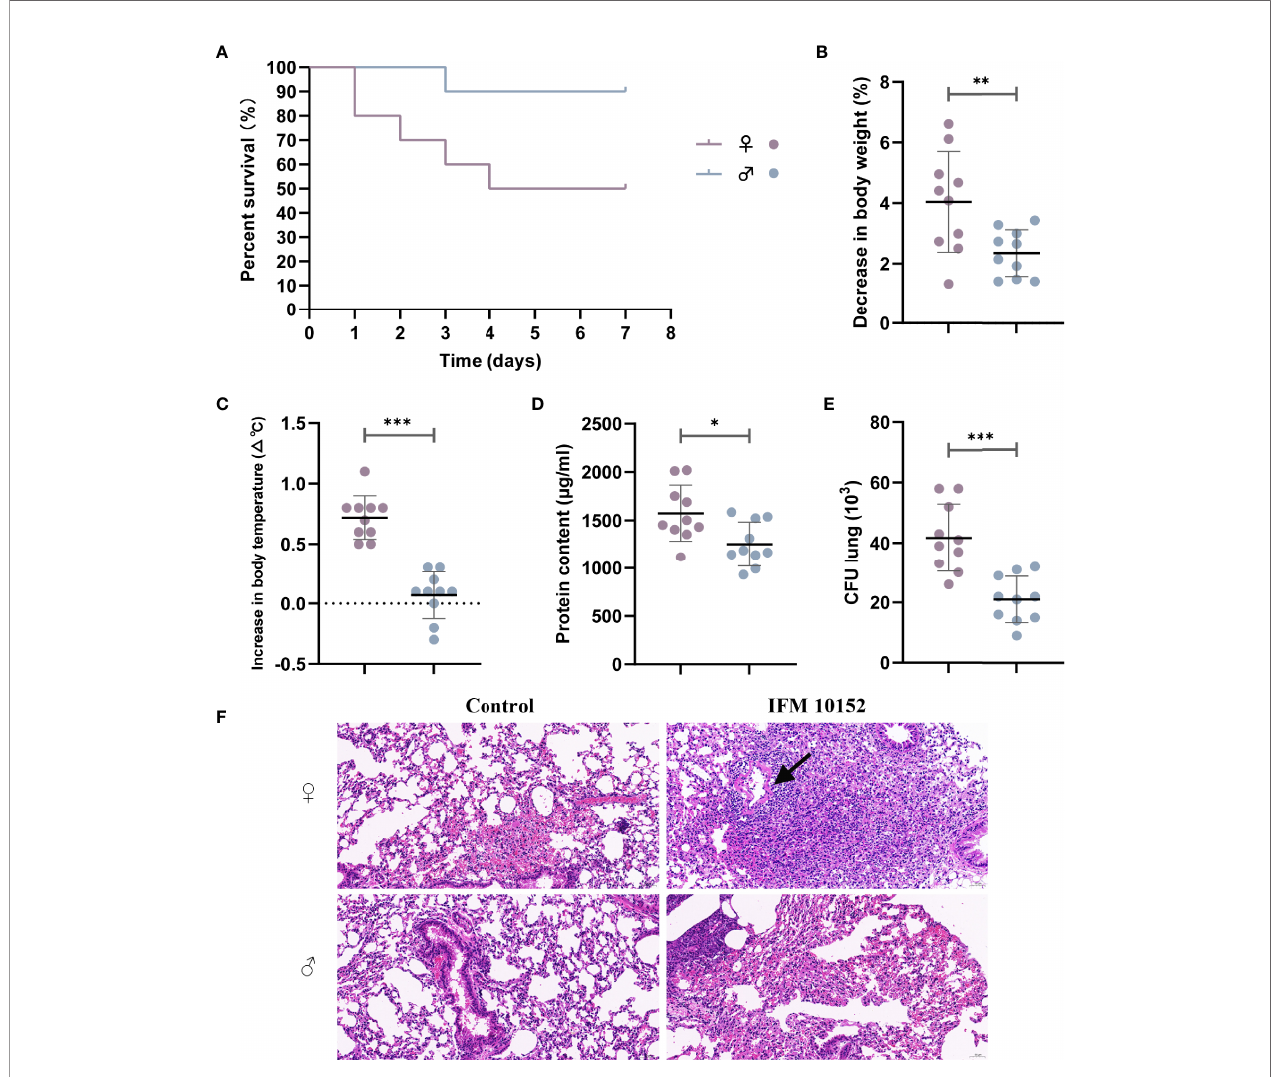
FIGURE 1 | Female mice are more susceptible to N. farcinica infection. (A) Female mice (n = 10) and male mice (n = 10) were injected intraperitoneally with 2×10 8 CFU (100 µl) of N. farcinica IFM 10152, and mortality was assessed for 14 days until no additional deaths were observed. (B – F) Female mice (n = 12) and male mice (n = 12) were infected intranasally with 1×10 7 CFU (50 µl) for 24 hours, and control groups were infected with 50 µl of PBS. (B) Change in body weight of mice. (C) Change in body temperature. (D) Protein content in BALF. (E) Bacterial burden in lung homogenates. (F) Representative H&E-stained lung sections of mice. Scale bars: 100 µm. Each point represents a mouse. Lines display means with SEM. Data are from 3 independent experiments. * P < 0.05, ** P < 0.01, and *** P <